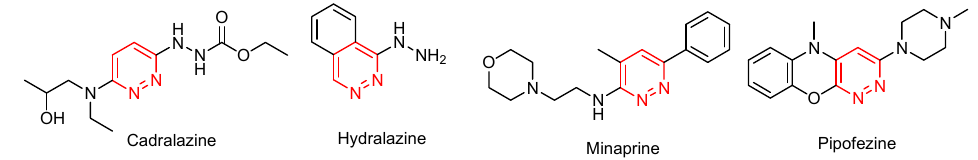
Figure 1. Some example of common drugs based on pyridazine rings. Molecules 2017 , 22 , 148;